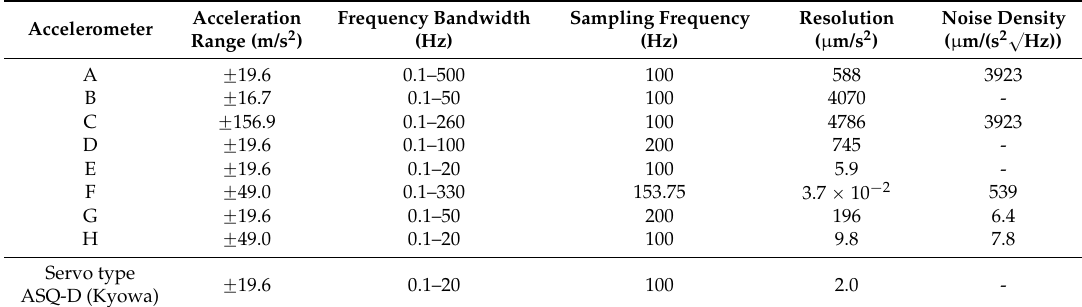
Table 2. Specifications of commercial accelerometers used to determine bridge displacement.